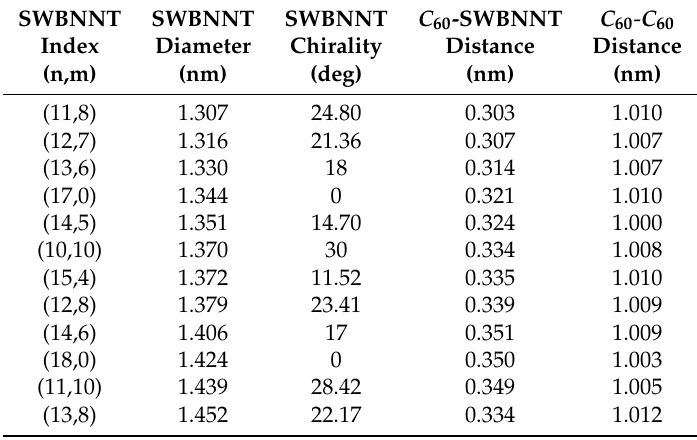
Table 1. Optimized structural parameters of the C 60 molecules inside SWBNNT in diameter range where the C 60 molecules adopt a linear chain inside